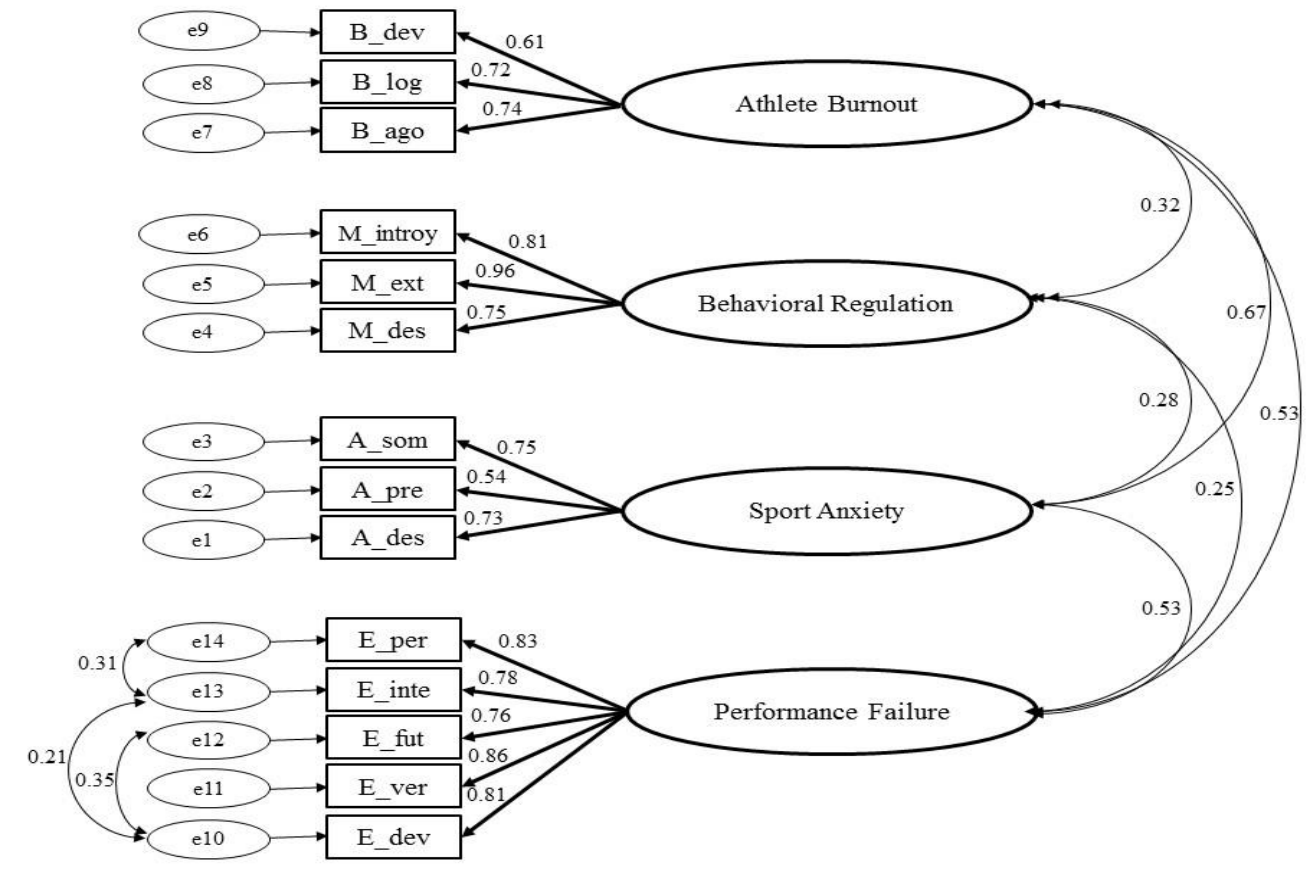
Figure 1. CFA with standardised coefficients and correlations between constructs.